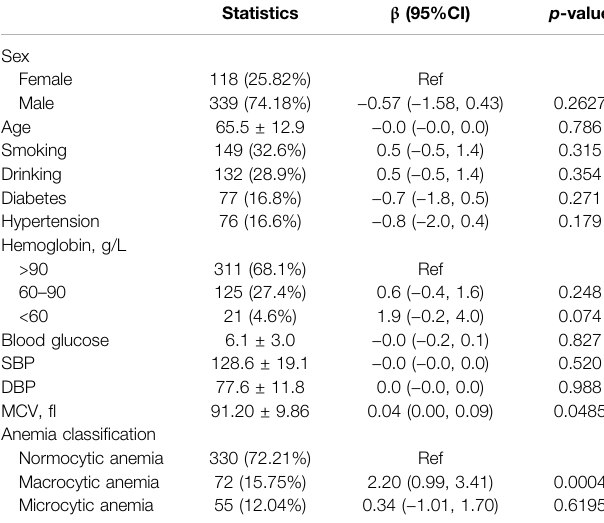
TABLE 2 | Univariate analysis for MELD